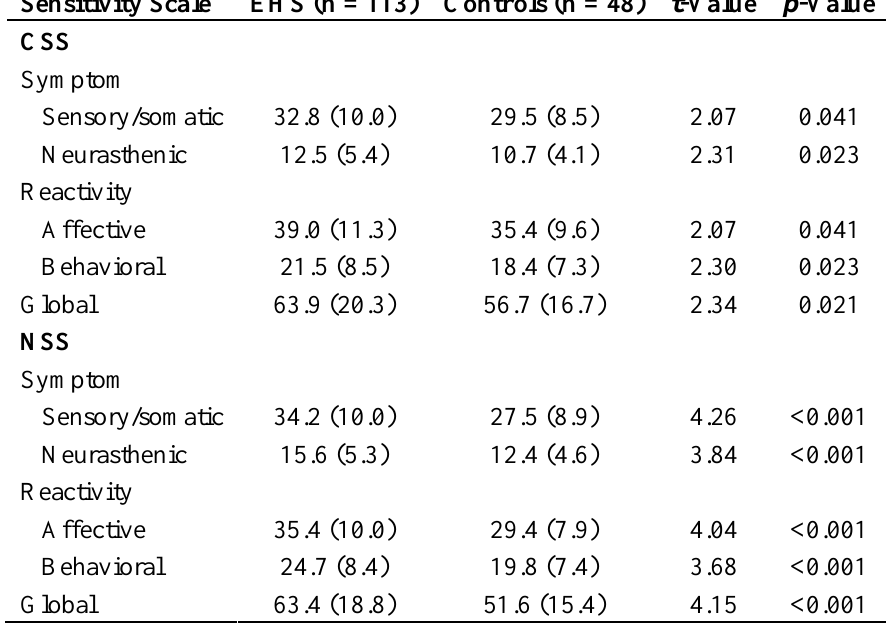
Table 3. Mean (SD) scores on the subscales and global measures of the Chemical Sensitivity Scale (CSS) and Noise Sensitivity Scale (NSS) in the group with electromagnetic hypersensitivity (EHS) and the control group. Results from t -tests comparing the two groups are given.